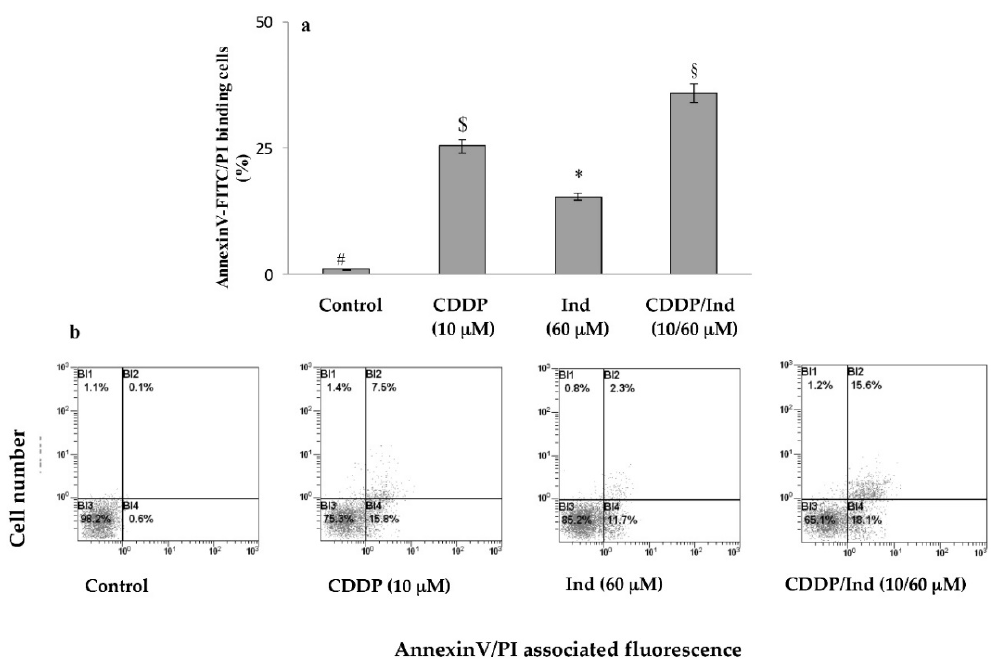
Figure 3. Apoptosis induced by CDDP, Ind and CDDP / Ind combination on HeLa cells. Cells were treated for 24 h as described in Methods. Percentage of AnnexinV / PI double stained-HeLa cells were determined by flow cytometer and compared to untreated cells (control). ( a ) Mean values ± SD of three separate experiments in triplicate. Bars without a common symbol are significantly di ff erent with p < 0.05 (one-way Anova associated with Tukey’s post hoc test); ( b ) Representative images: BI3, viable cells (AnnexinV − / PI − ); BI4, cells in early apoptosis (AnnexinV +/ PI − ); BI2, cells in tardive apoptosis